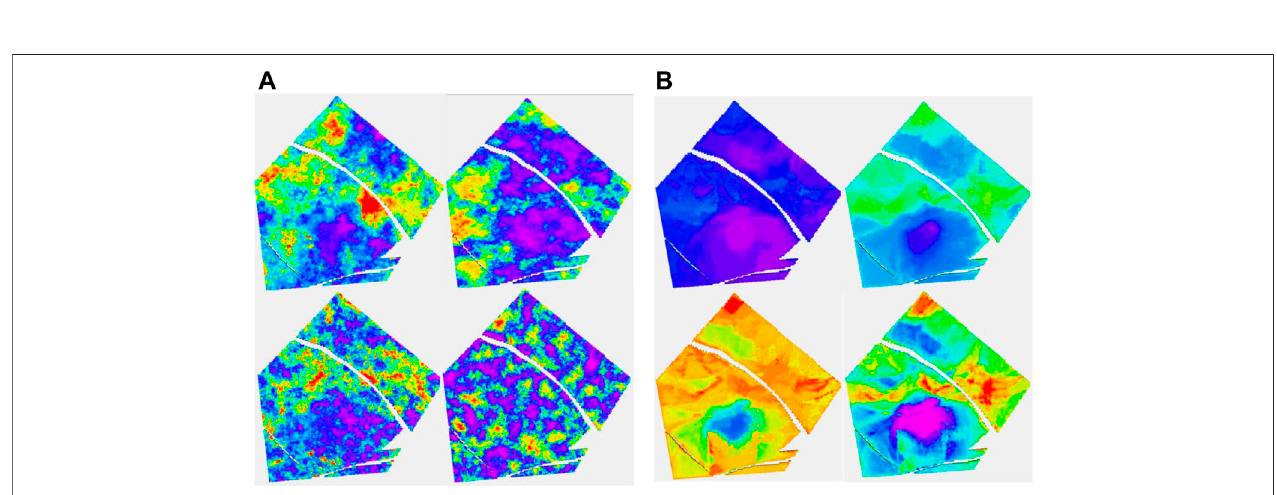
FIGURE 6 | (A, B) Eight-well case. (A) Clockwise, Ember simulation-good variogram (G.V), Gaussian simulation (G.V), Gaussian simulation-poor variogram (P.V), and Ember simulation (P.V). (B) Clockwise, Ember quantiles: P10, P50, prob (porosity > 20%), and P90.